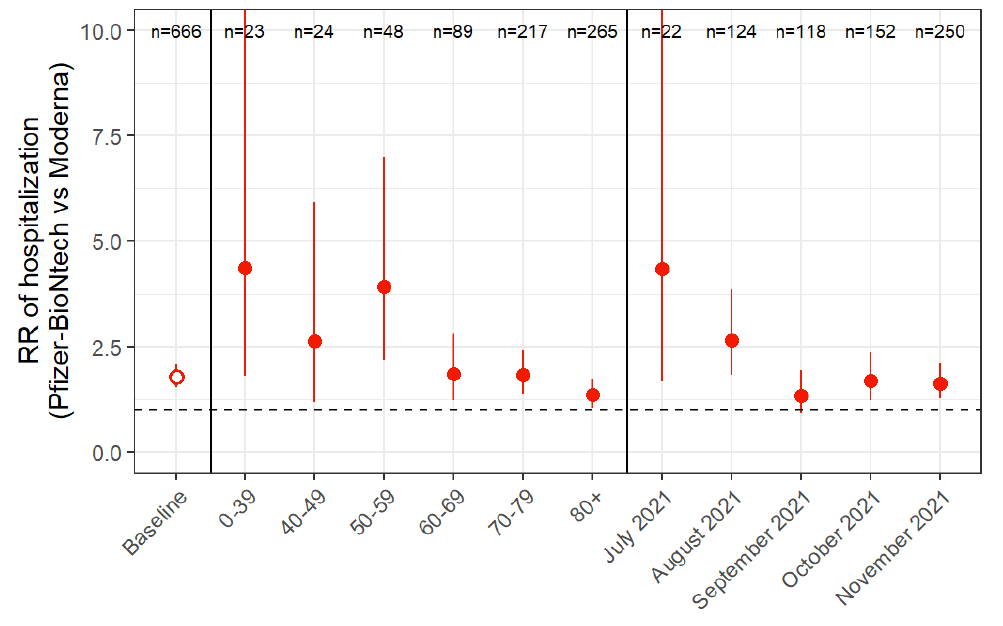
Figure S4. Relative change in the RR of hospitalization for individuals fully-vaccinated with Pfizer- BioNtech compared to individuals fully-vaccinated with Moderna, overall, by age group, and by month.